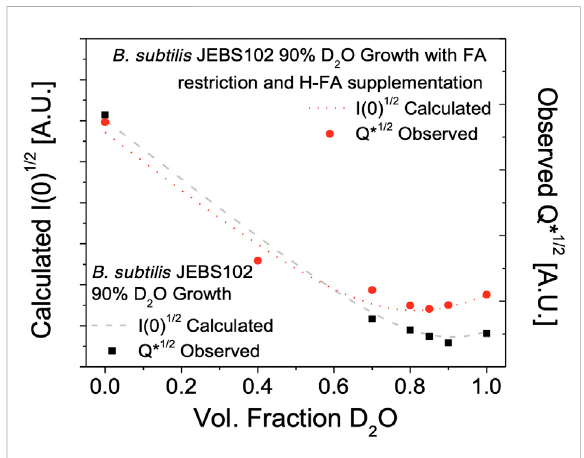
FIGURE 3 Total neutron scattering from B. subtilis JEBS102 cells grown in 90% D 2 O growth conditions, with or without FA restriction and supplementation using the procedures described as a function of D 2 O content in the resuspension buffer. Total scattering was assessed as the Porod invariant, Q* , over the range from 0.009 Å − 1 < q < 0.06 Å − 1.Thisiscomparedto theestimatedtotal scattering intensity I(0) based on a model (Nickels et al., 2017b) of estimated biomolecule content and scattering length density. The incorporation of hydrogenated FAs in the partially deuterated cells leads to the observed increase in scattered intensity of FA labeled cells at high fractions of D 2 O in the resuspension